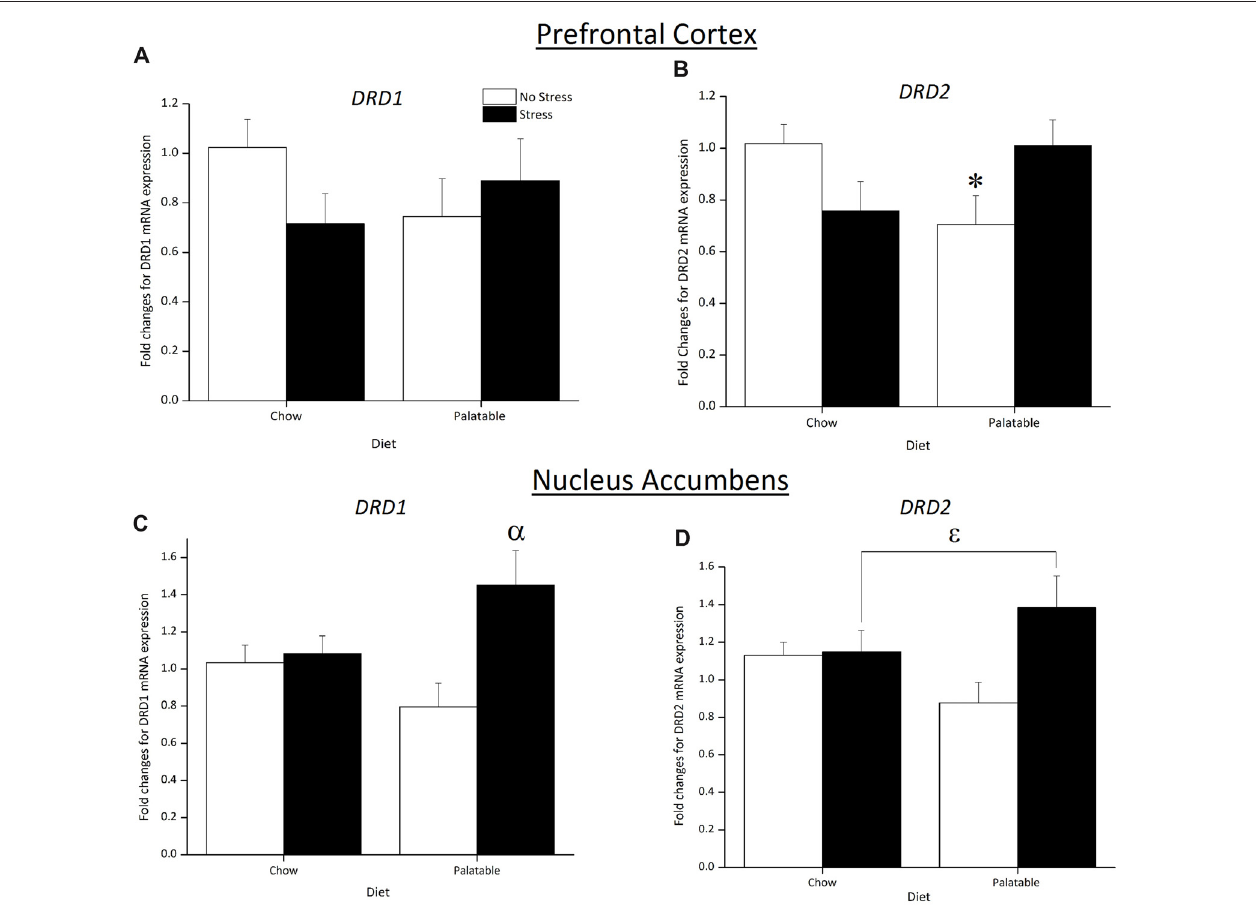
FIGURE 6 | Effect of juvenile stress and diet on fold changes for dopamine (DA) receptors mRNA expression in the prefrontal cortex (PFC) and nucleus accumbens (NA). (A) There were no significant changes in DRD1 expression across groups in the PFC. (B) DRD2 expression in the PFC was downregulated in non-stressed rats fed the palatable diet. (C) There was an upregulation in DRD1 expression in juvenile stressed rats with access to palatable food in the NA (D) DRD2 expression was upregulated in juvenile stressed rats with access to palatable food however this did not reach significance in the NA. ∗ Significantly different from stressed palatable diet group and non-stressed chow group ( p < 0.05). α Significantly different from non-stressed palatable diet group ( p < 0.05). ε Significantly different from non-stressed groups ( p <